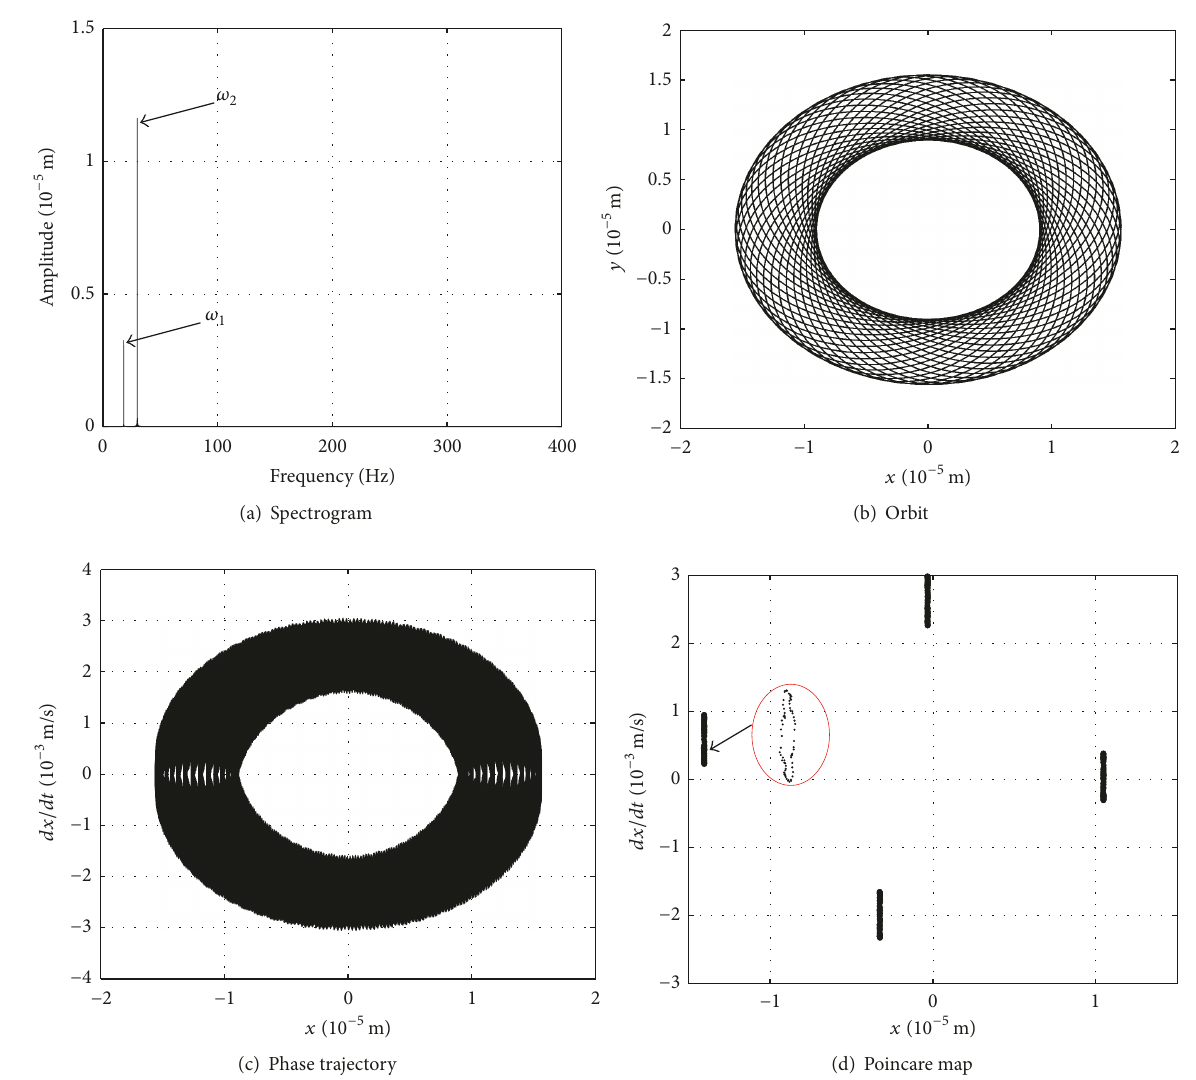
Figure 12: Response analysis of disk 2: 𝜔 1 = 114 rad / s and 𝜆 = −1.65